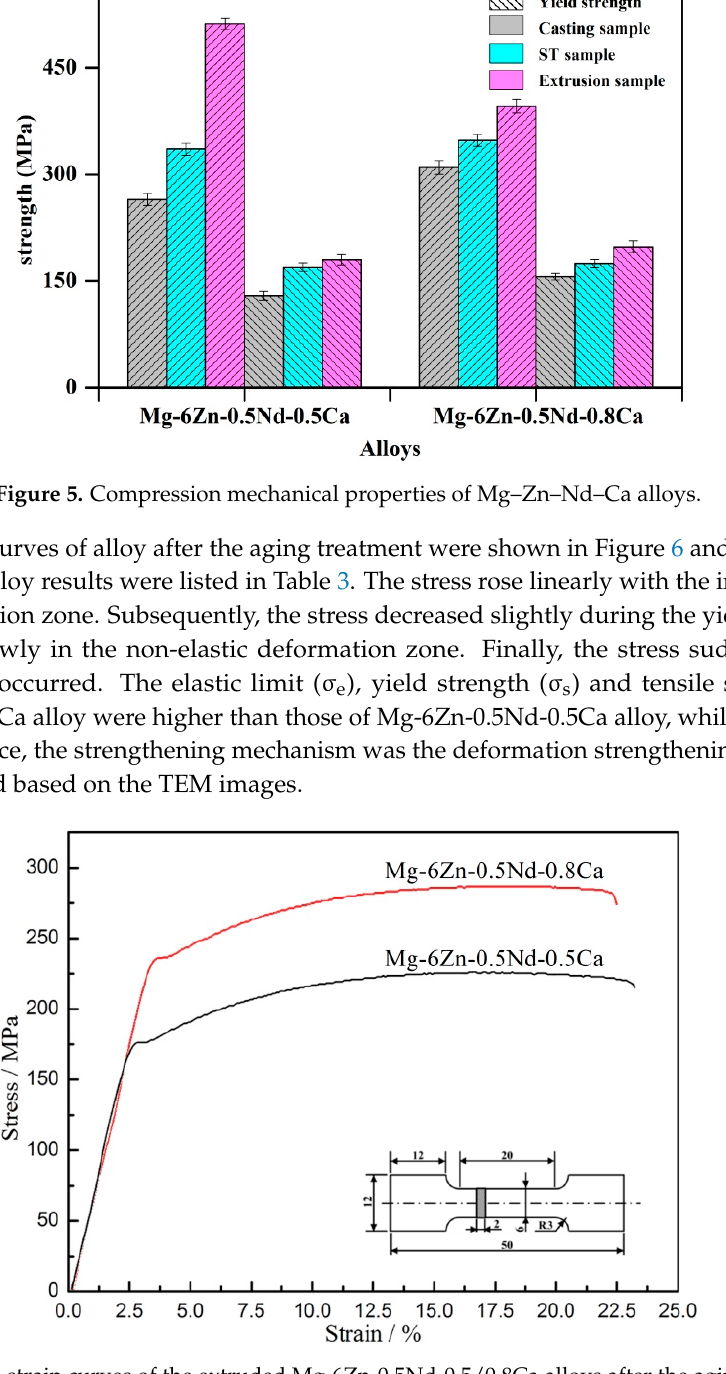
Figure 6. Stress-strain curves of the extruded Mg-6Zn-0.5Nd-0.5/0.8Ca alloys after the aging treatment and the dimensions of tensile specimen (unit: mm). Table 3. Mechanical properties of the extruded Mg-6Zn-0.5Nd-0.5/0.8Ca alloys after the aging treatment.